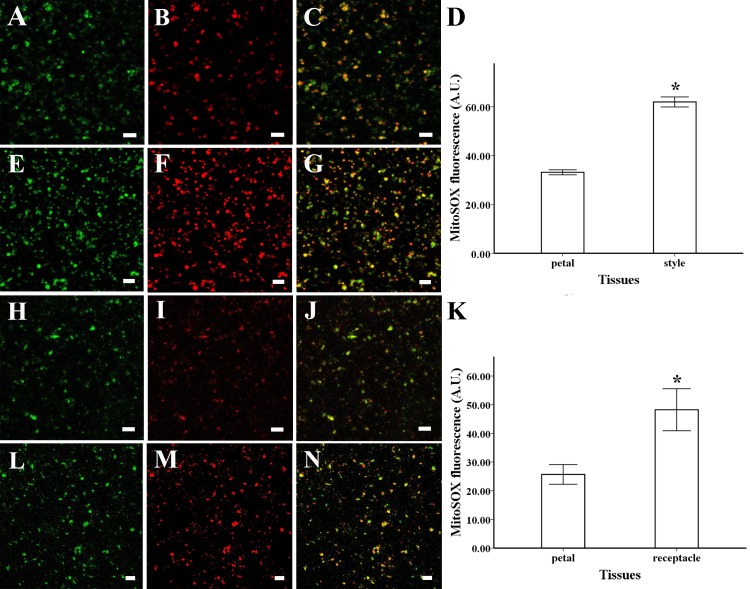
ROS production and colocalization with mitochondria.ROS production and colocalization with mitochondria isolated from M. denudata: mitochondria isolated from petal (A) and style (E) were visualized by Mito Tracker Green (in green color), mitochondrial ROS in mitochondria isolated from petal (B) and mitochondria isolated from style (F) was visualized by MitoSOX red (in red color), colocalization of ROS and mitochondria in petal (C) and style (G). (D) Comparison of ROS fluorescent intensity in petal and style of M. denudata. ROS production and colocalization with mitochondria isolated from N. nucifera: mitochondria isolated from petal (H) and receptacle (L) were visualized by Mito Tracker Green (in green color), mitochondrial ROS in mitochondria isolated from petal (I) and mitochondria isolated from style (M) was visualized by MitoSOX red (in red color), colocalization of ROS and mitochondria in petal (J) and receptacle (N). K. Comparison of ROS fluorescent intensity in petal and receptacle of N. nucifera. Scale bar: 5 µm.